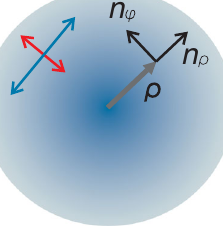
FIG. 3. Transverse radius-vector ρ and the directions n ρ , n φ of extremal scattering intensities at the background of the string field. The double-sided arrows portray the excess of azimuthal scattering over the radial